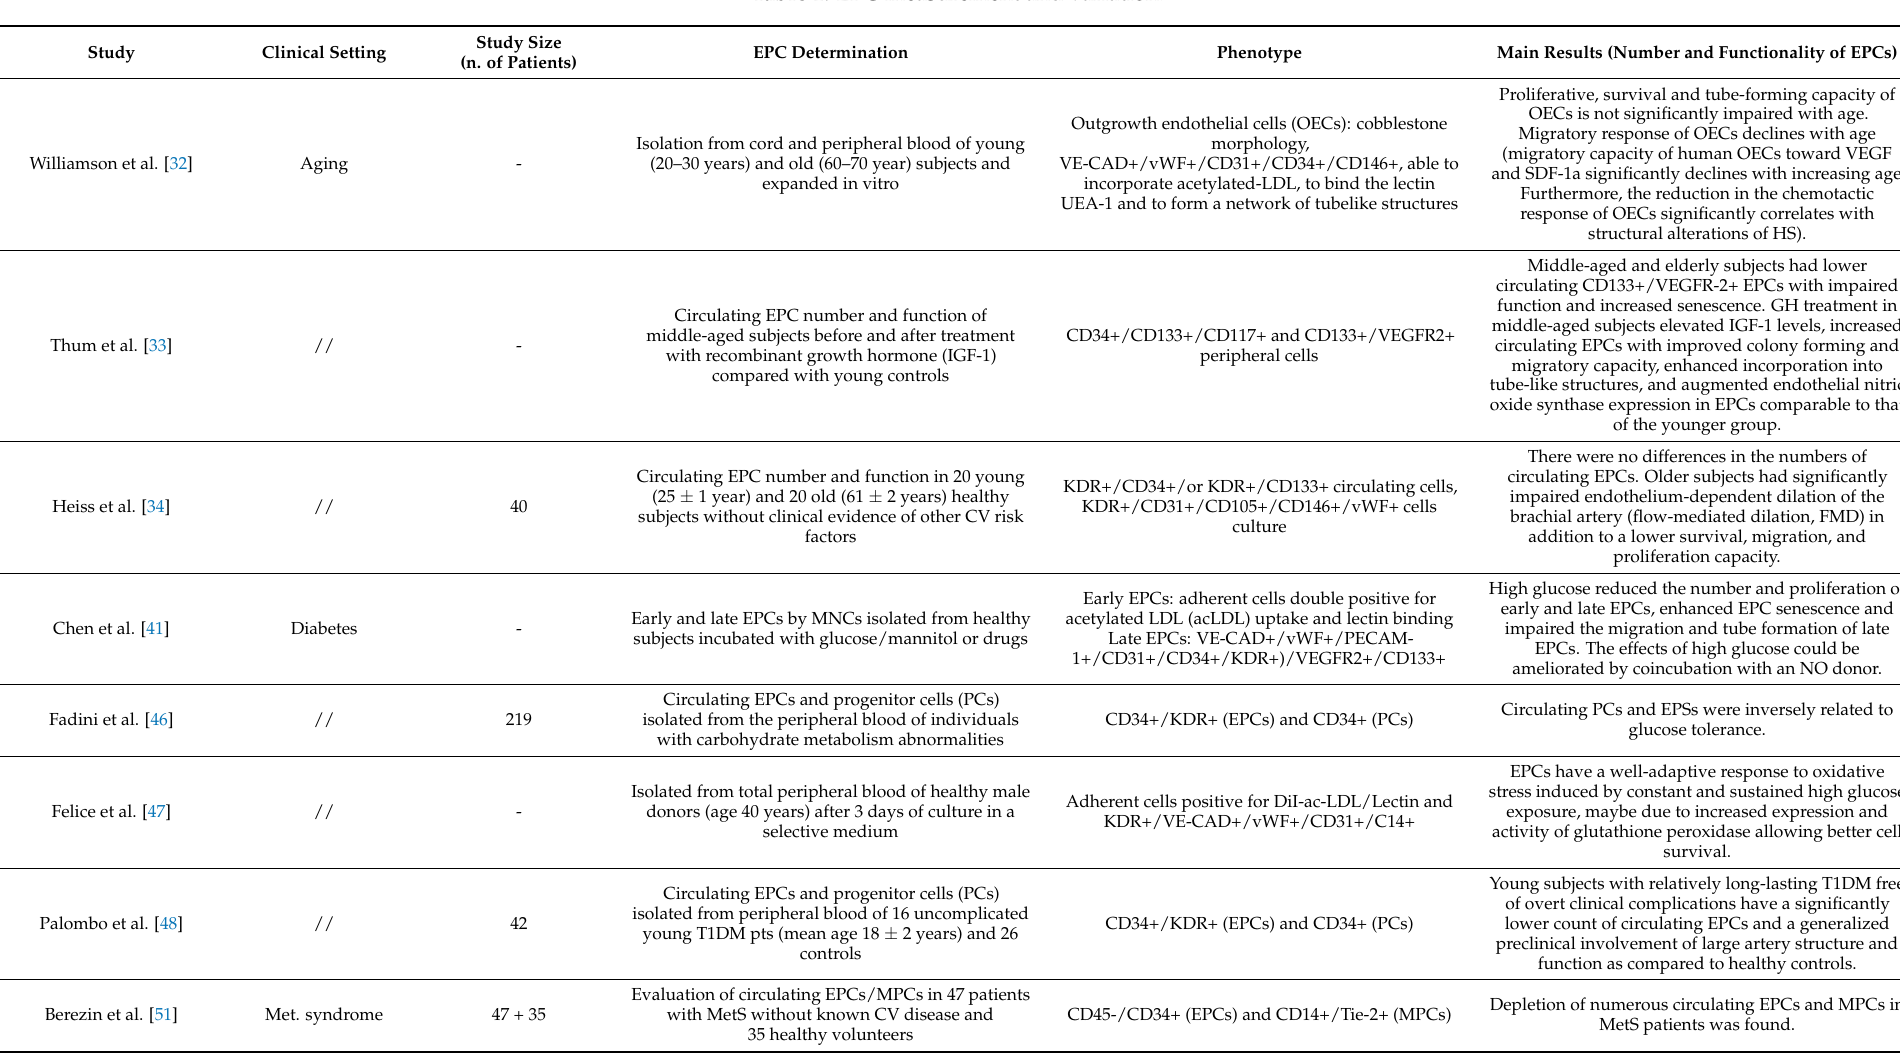
Table 1. EPC measurement and